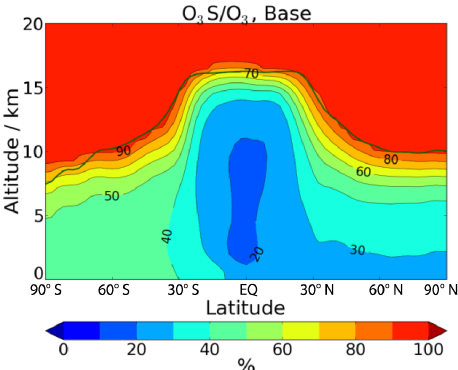
Figure 6. The zonal and annual mean contribution of O 3 S to ozone in the Base simulation. The solid green line indicates the thermal tropopause of the Base